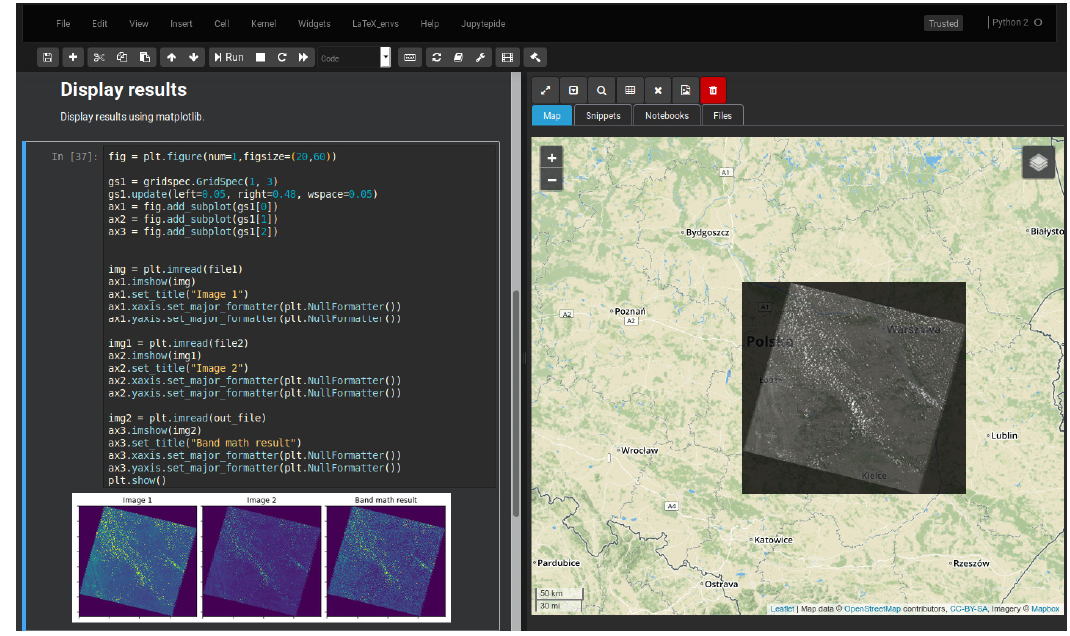
Figure 15. The result of processing.